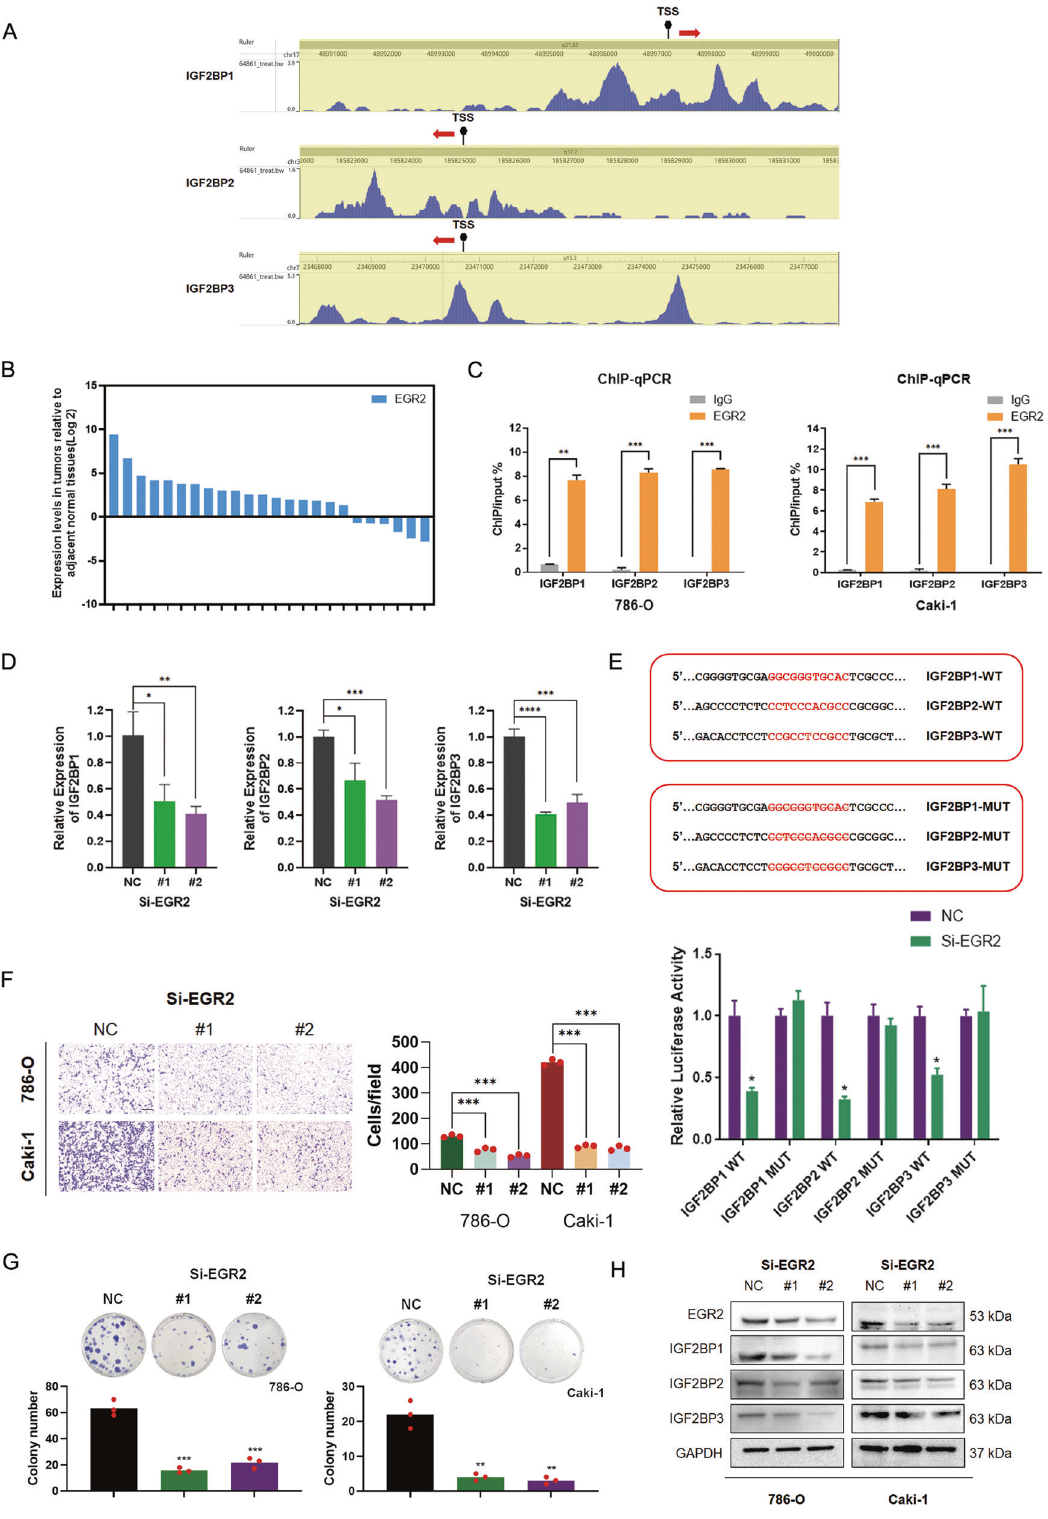
Fig. 2 EGR2 contributes to the deregulation of IGF2BPs in RCC patients and promotes RCC migration and proliferation. A Enriched peaks were identi fi ed using the ChIP-seq data. B EGR2 were elevated in 18 (75%) RCC tissues relative to adjacent nonmalignant tissues. C RT-qPCR analyses for ChIP using EGR2 antibodies were performed. D The mRNA levels of IGF2BP1-3 were markedly decreased with EGR2 knockdown. E Reporter gene analysis using the luciferase reporter construct individually driven by the IGF2BPs promoters (shown schematically at the bottom). F , G Knockdown of EGR2 suppressed migration and proliferation viabilities in RCC cells. Scale bar 250 μ m. H Western blot assays were performed to identify the protein levels of IGF2BP genes when EGR2 was knockdown. Values in C , D , and E are mean ± SEM. * P < 0.05; ** P < 0.01; *** P <